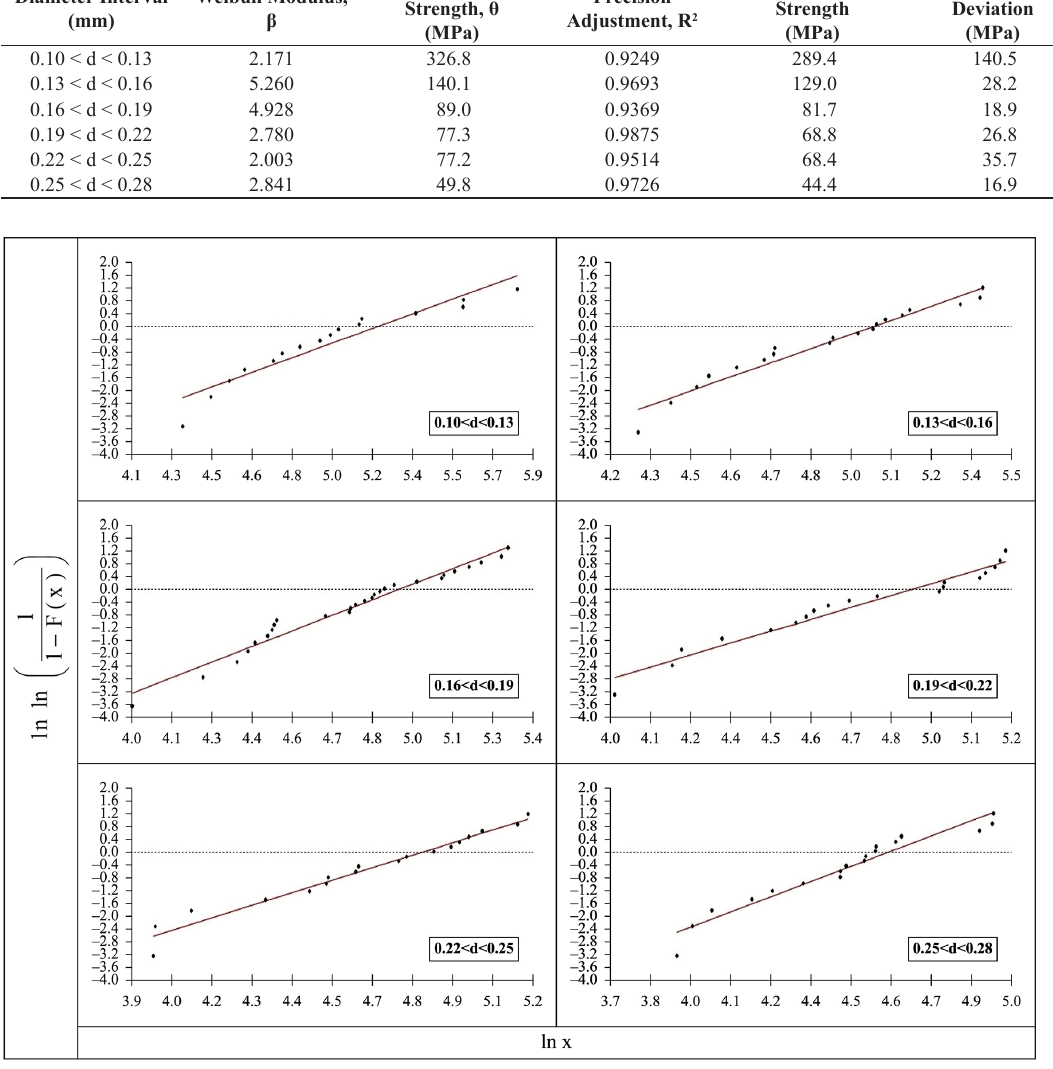
Figure 6. Weibull diagrams for PALF tensile strength in different intervals of diameter.